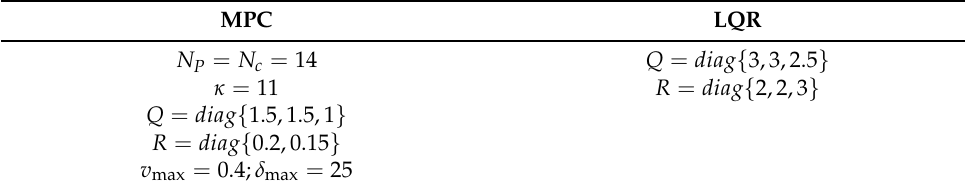
Table 4. MPC and